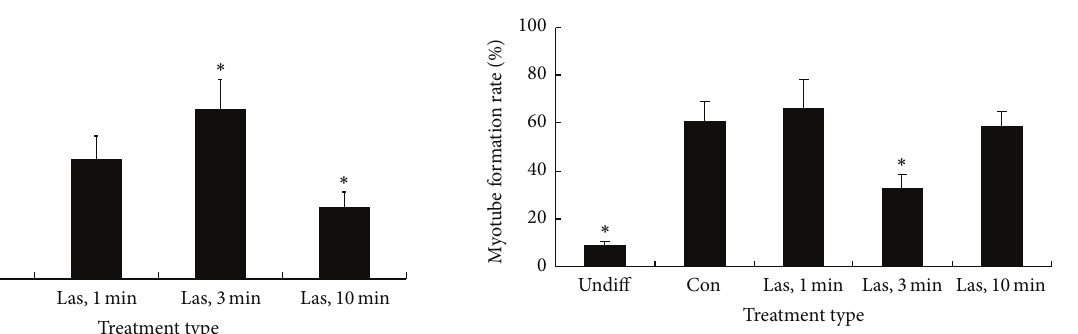
Figure 2: Effects of LPLI with different irradiation times on myoblasts growth capacity by cell counting. The data were from three independent experiments. Each bar represents mean ± SD. ∗ 𝑃 < 0.05 as compared with control group. Con: control; Las: laser irradiation.